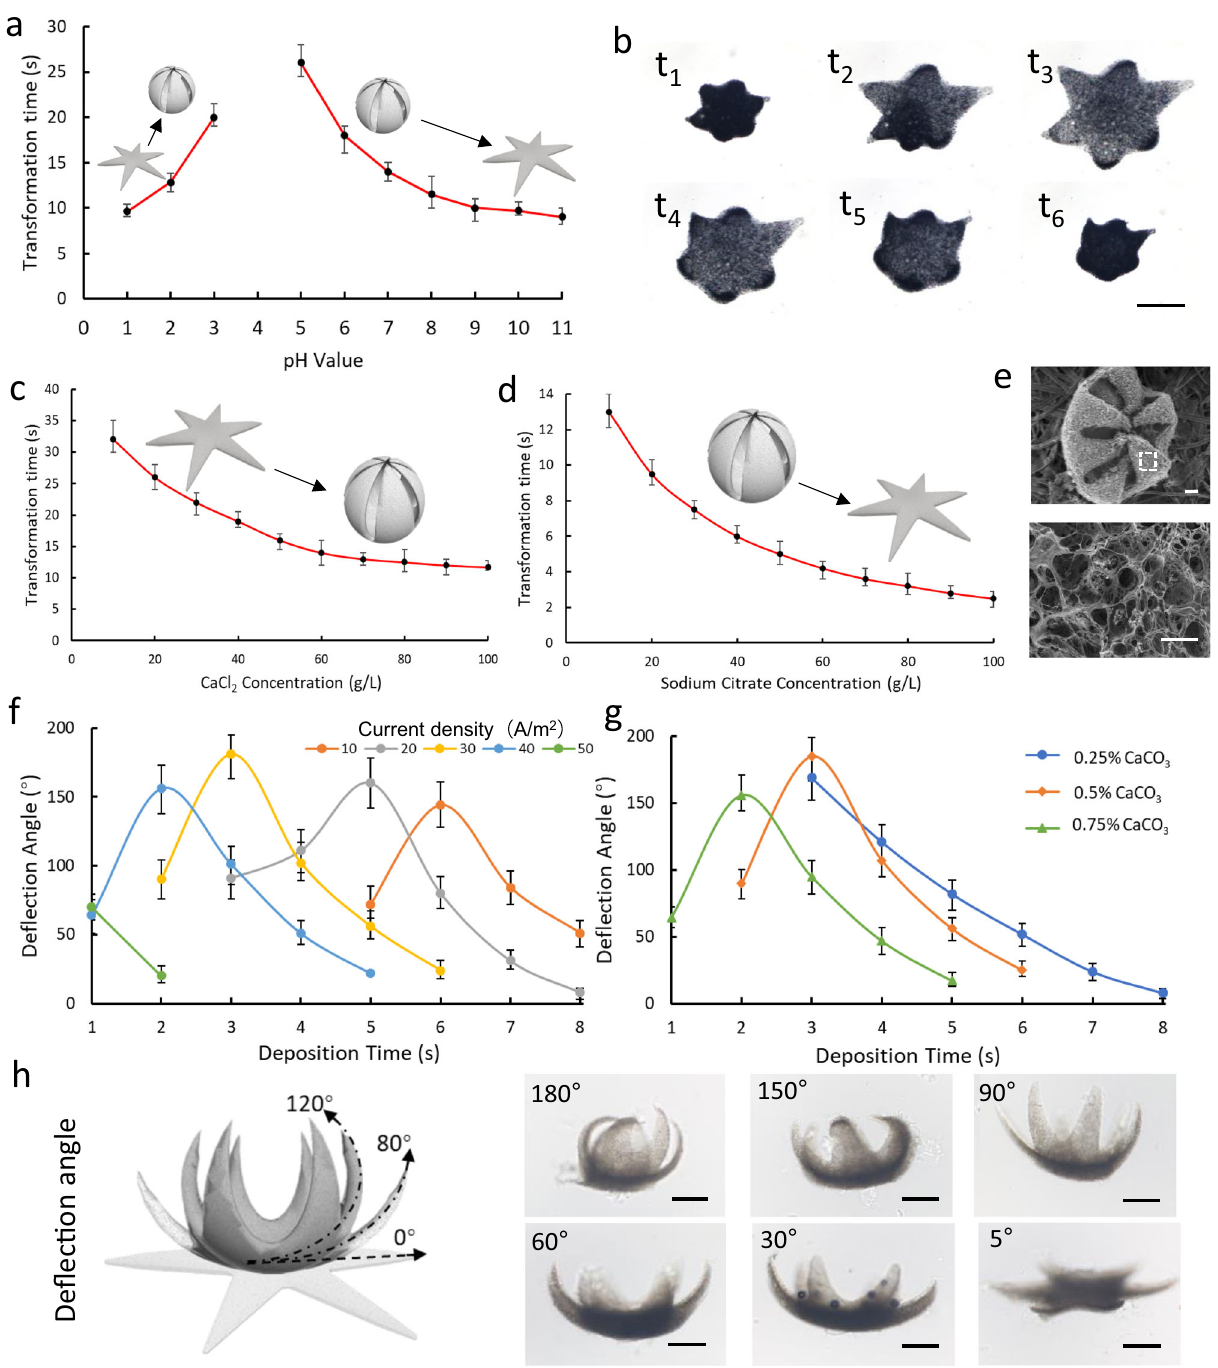
Fig. 3 Process parameters of ISME transformation. a Time for an ISME to accomplish transformation in response to stimulation with different pH values. Each dot represents the average transformation time for fi ve different ISMEs under pH shift with hexagram shapes ± s.e.m. (standard error of the mean). In the pH 1 – 4, the ISME represent the shrinkage. In the pH 5 – 11, the ISME represent the swelling. b Reversible transformation of ISME in response to pH changes. Scale bar: 500 μ m. c Time for an ISME to accomplish shrinkage under different calcium ion concentrations. Each dot represents the average transformation time ISMEs with hexagram shapes ± s.e.m. N = 5. d Time for an ISME to accomplish swelling under different sodium citrate concentrations. Each dot represents the average transformation time ISMEs with hexagram shapes ± s.e.m. N = 5. e SEM images of the ISMEs. Scale bar: 10 μ m. f De fl ection angle of the fi nger part of an ISME formed with different current densities and deposition times. Each dot represents the average de fl ection angle structures with hexagram shapes ± s.e.m. N = 5. g De fl ection angle of the fi nger part of an ISME formed with different calcium carbonate concentrations and different deposition times. Each dot represents the average de fl ection angle structures with hexagram shapes ± s.e.m. N = 5. h Images of an ISME with different de fl ection angles. The de fl ection angle represents the de fl ected angle from before to after deformation. Scale bar: 250 μ m. Source data is provided as a Source Data fi